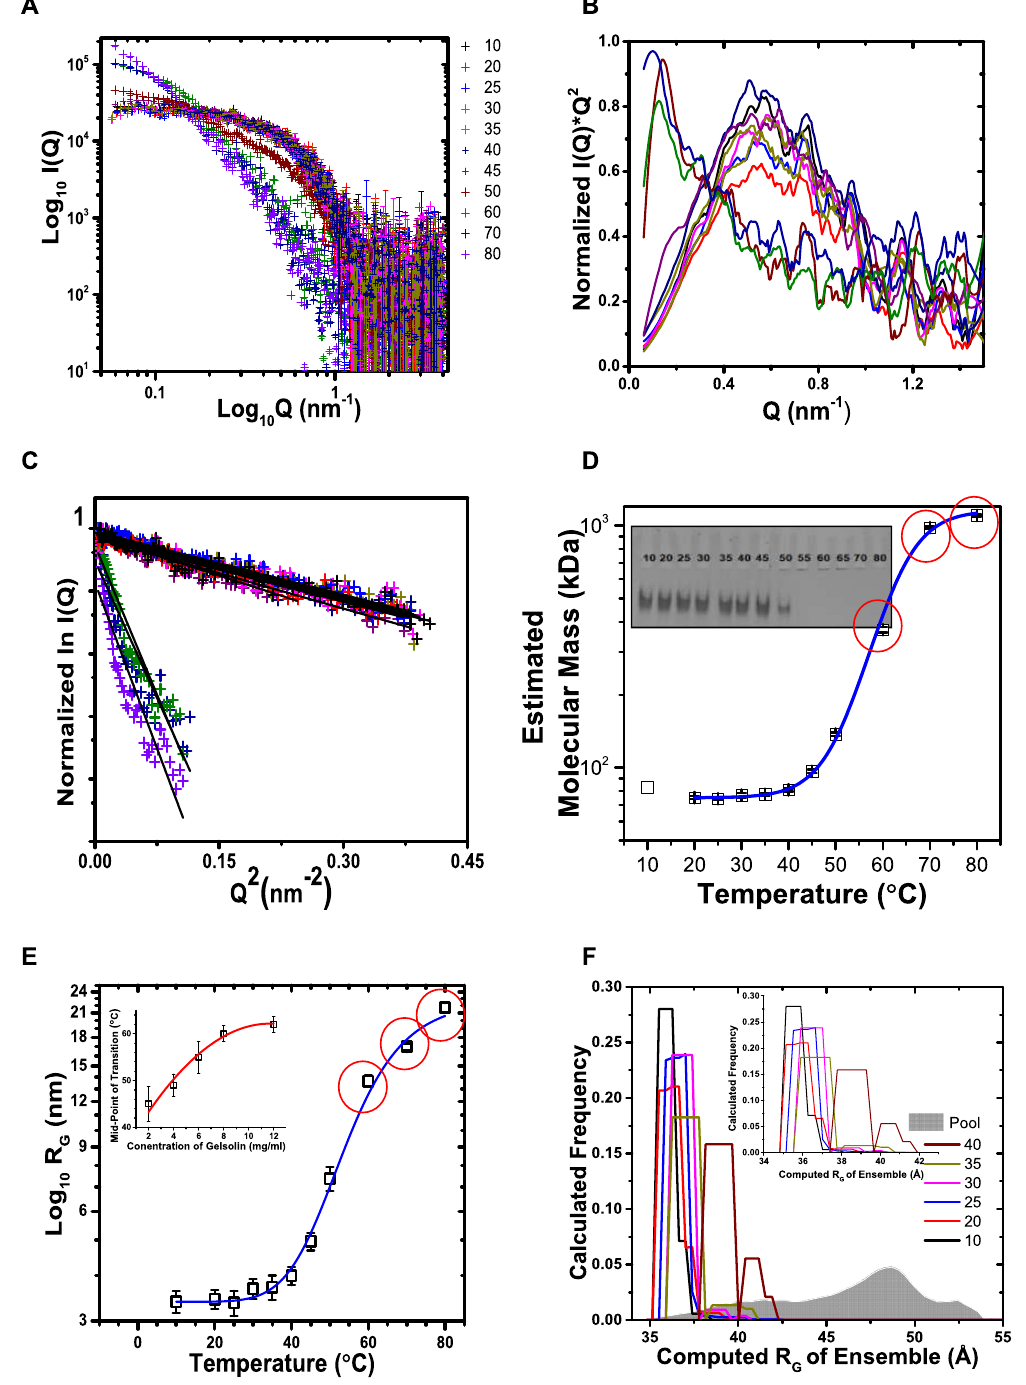
Figure 2. ( A ) The SAXS I(Q) profiles of gelsolin (8 mg/ml) at different temperatures in buffer lacking any free Ca 2 + and pH 8 are plotted here. ( B ) This panel shows the Kratky plots of the SAXS datasets shown in panel (A). The smoothened versions were generated by averaging adjacent 5 data points). ( C ) The Guinier analysis of all the datasets presuming globular scattering profiles are shown here. ( D ) Variation in the molecular mass of the gelsolin molecules estimated using I 0 values from Guinier analysis as a function of temperature are plotted here. The blue line represents the Sigmoidal fit to the data presuming two-state transition. Inset shows the image of the native PAGE of the heated samples. Red circles indicate samples where slight aggregation was visible and thus indicate uncertainty in estimation. ( E ) Variation in the R G values as a function of temperature for gelsolin solution is plotted here (black squares). The blue line fitted through symbols shows the Sigmoidal fit to the observed trend in the increase of R G values. The point of half-change for R G values in samples varying in gelsolin concentration are shown in inset. ( F ) Variation in the calculated R G values of the different conformations present in the ensemble as a function of temperature of experiment are presented against the pool of random conformations